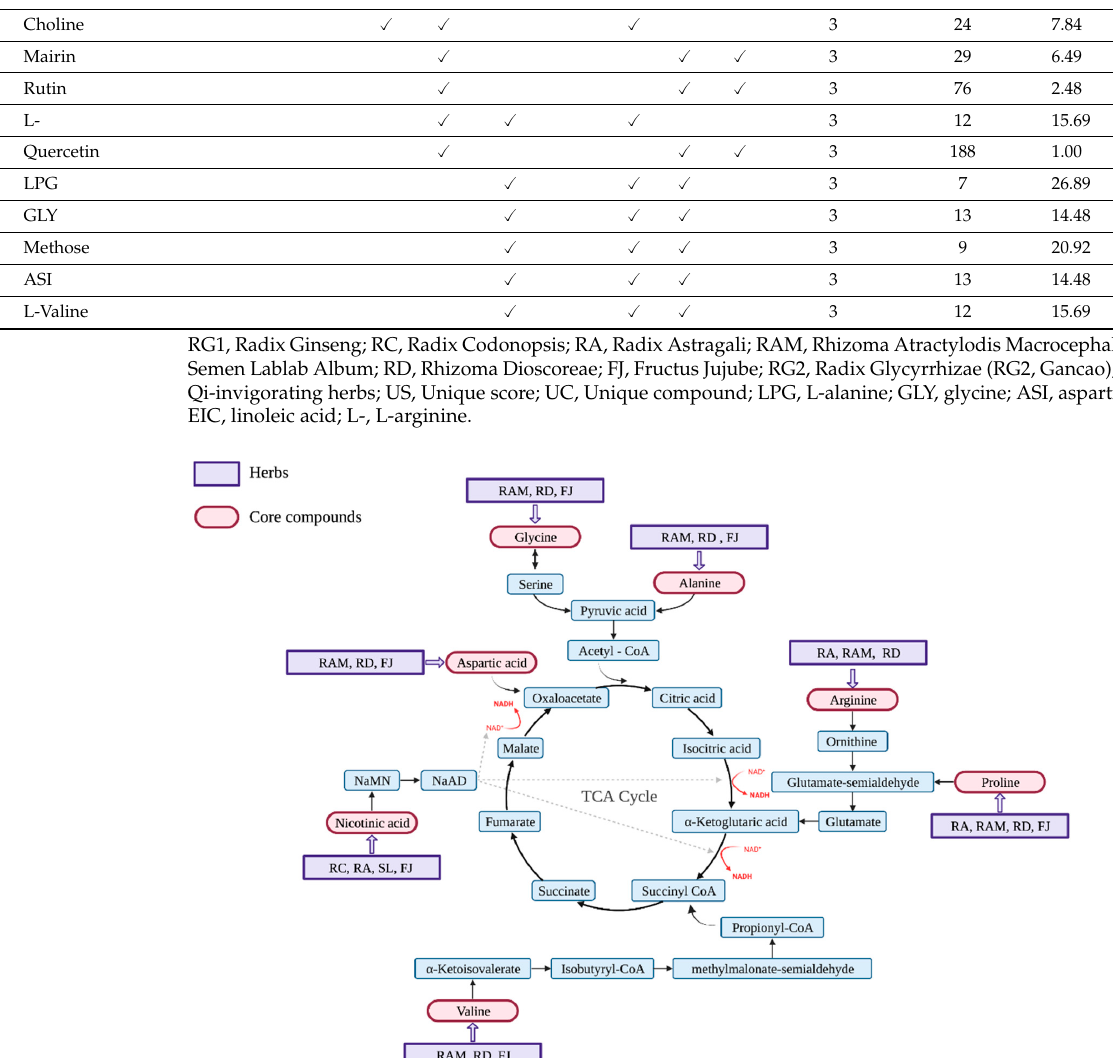
Using the TCMSP, BATMAN-TCM, and SwissTargetPrediction databases, 13 lists of targets of unique compounds were obtained, including 34 targets of darutoside, 152 tar- gets of nicotinic acid, 114 targets of proline, 18 targets of 20-hexadecanoylingenol, 116 tar- gets of 12-O-nicotinoylisolineolone, 148 targets of choline, 113 targets of mairin, 157 tar- gets of L-arginine, 449 targets of L-alanine, 506 targets of glycine, 43 targets of methose, 447 targets of aspartic acid, and 427 targets of L-valine. After inputting the 13 lists of targets of unique compounds into the DAVID database, KEGG pathway enrichment analysis revealed 46 signaling pathways of darutoside, 25 of nicotinic acid, 11 of proline, 8 of 20-hexadecanoylingenol, 132 of 12-O-nicotinoylisolineo- lone, 27 of choline, 26 of mairin, 17 of L-arginine, 44 of L-alanine, 50 of glycine, 8 of meth- ose, 44 of aspartic acid, and 44 of L-valine ( p < 0.01). As shown in Figure 3, unique com- pounds were mainly involved in neuroactive ligand–receptor interaction, metabolic path- ways, the calcium signaling pathway, arginine and proline metabolism, biosynthesis of amino acids, and arginine biosynthesis. The targets of the six amino acids and choline had many shared pathways. In addition, GO analysis showed that unique compounds were mainly involved in the responses to drugs, xenobiotic stimulus, ethanol, lipopolysaccha- ride, hypoxia, and glucocorticoid of the biological process category. Seven compounds were found to be involved in regulating the aging pathway. In the cell components cate- gory, the targets of the unique compounds were related to the components of mitochon- dria (mitochondrial inner membrane, mitochondrial outer membrane, and mitochondrial matrix) and neuronal cells (neuron projection, neuronal cell body, integral component of presynaptic membrane, postsynaptic membrane, synapse, dendrite, and perikaryon). Mo- lecular functions showed identical protein binding, enzyme binding, oxidoreductase ac- tivity, and protein homodimerization activity (Figure 4).